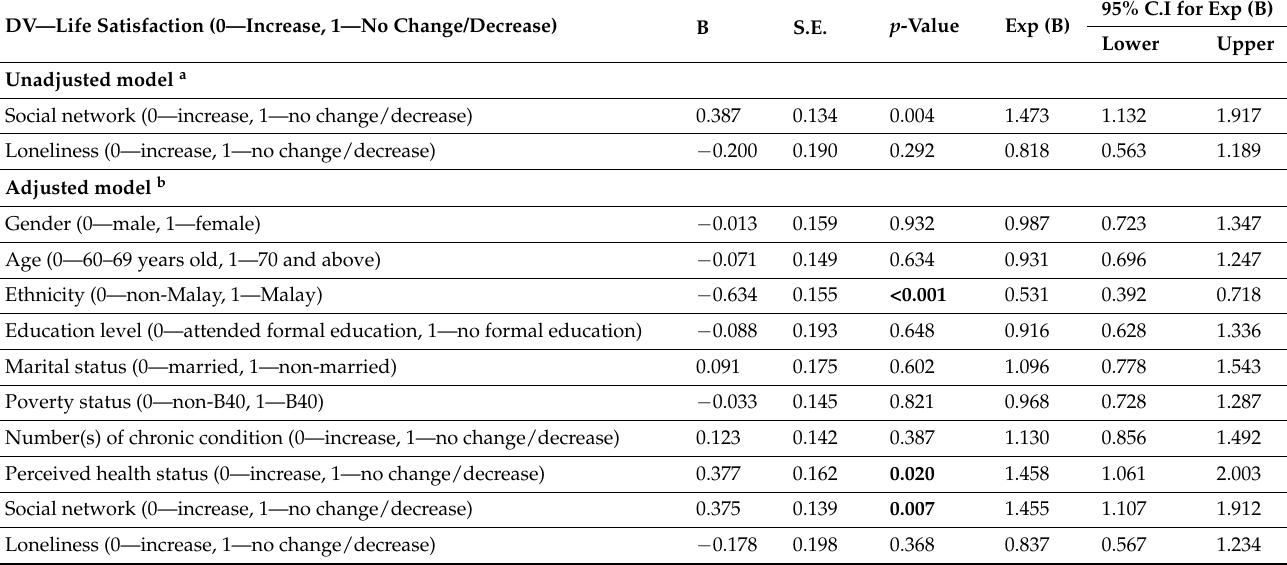
Table 3. Individual effects of social networks and loneliness on life